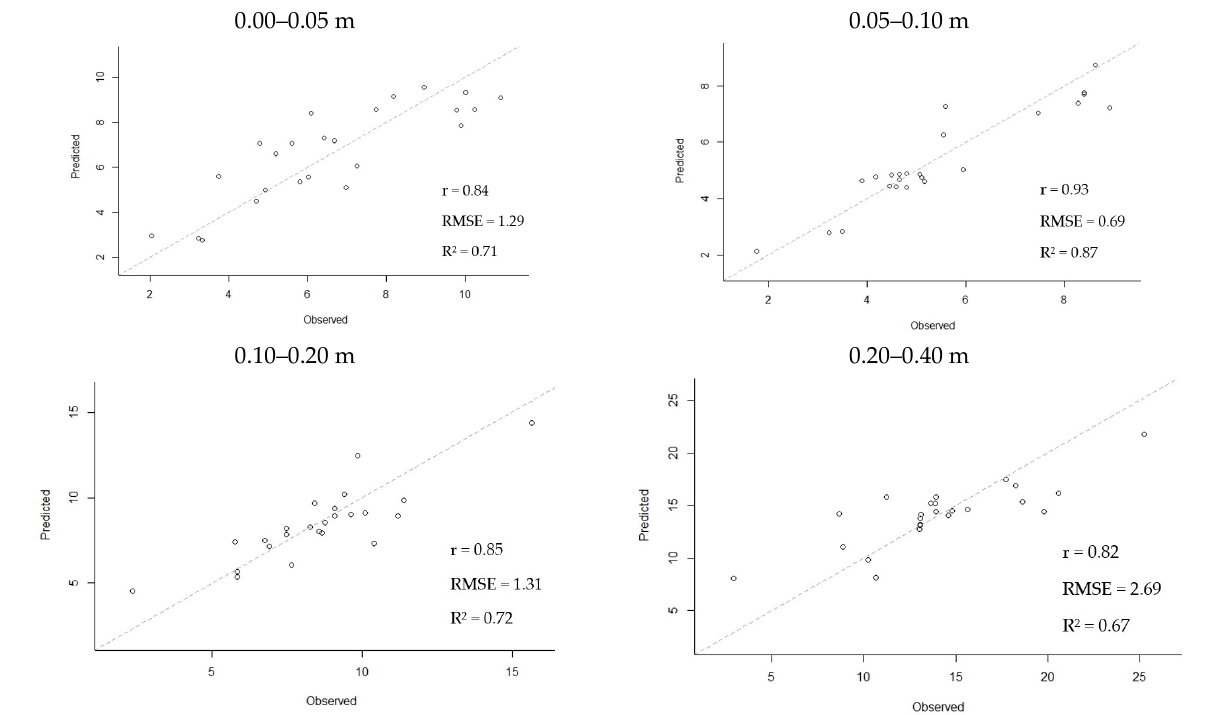
Figure 8. Validation of the Random Forest model to predict soil carbon stock for different land use systems: r—correlation coefficient, RMSE—root-mean-square error, and R 2 —determination coefficient.